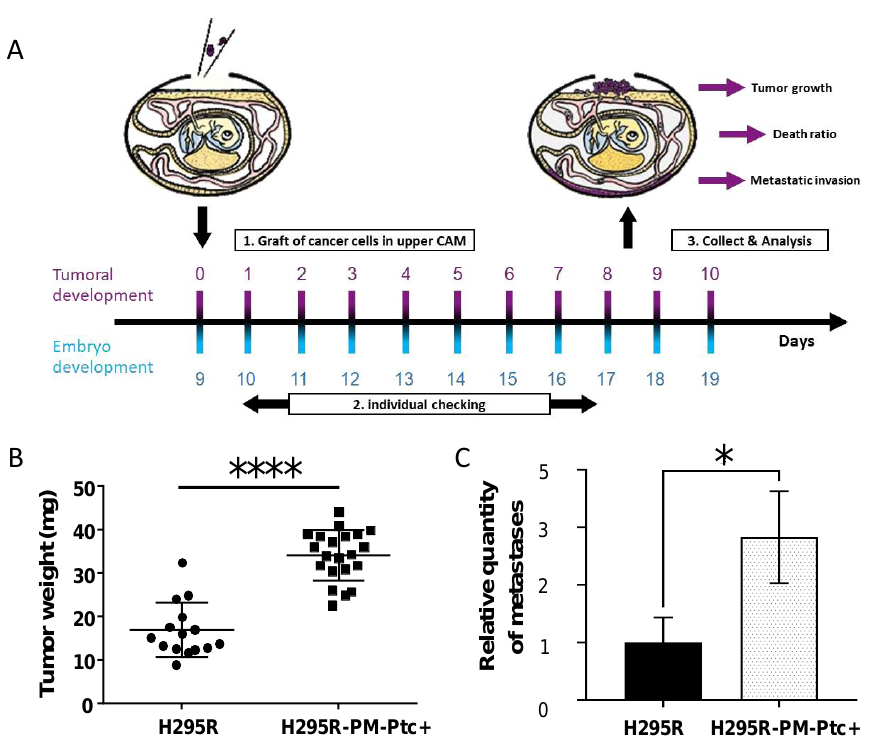
Figure 5. H295R-PM-Ptc+ cells are more tumorigenic and metastatic than parental ACC cells in ovo . ( A ) Schematic representation of the study. On day 9 of egg development (E9) 3 × 10 6 H295R- PM-Ptc+ and H295R cells were injected in the chorioallantoic membrane (CAM) from two groups of 20 eggs. At E18 tumors from CAM and embryos were collected. ( B ) H295R-PM-Ptc tumors collected on E18 were bigger than H295R tumors ( n = 15 for H295R graft and n = 21 for H295R-PM-Ptc+; ****: p -value < 0.00005). ( C ) Metastasis in liver was addressed using human Alu sequences by real time qPCR. H295R-PM-Ptc+ xenografted cells form more metastases in the embryo liver compared to H295R xenografted cells (mean ± SEM n = 9, *: p -value < 0.05 ( p = 0.03)).